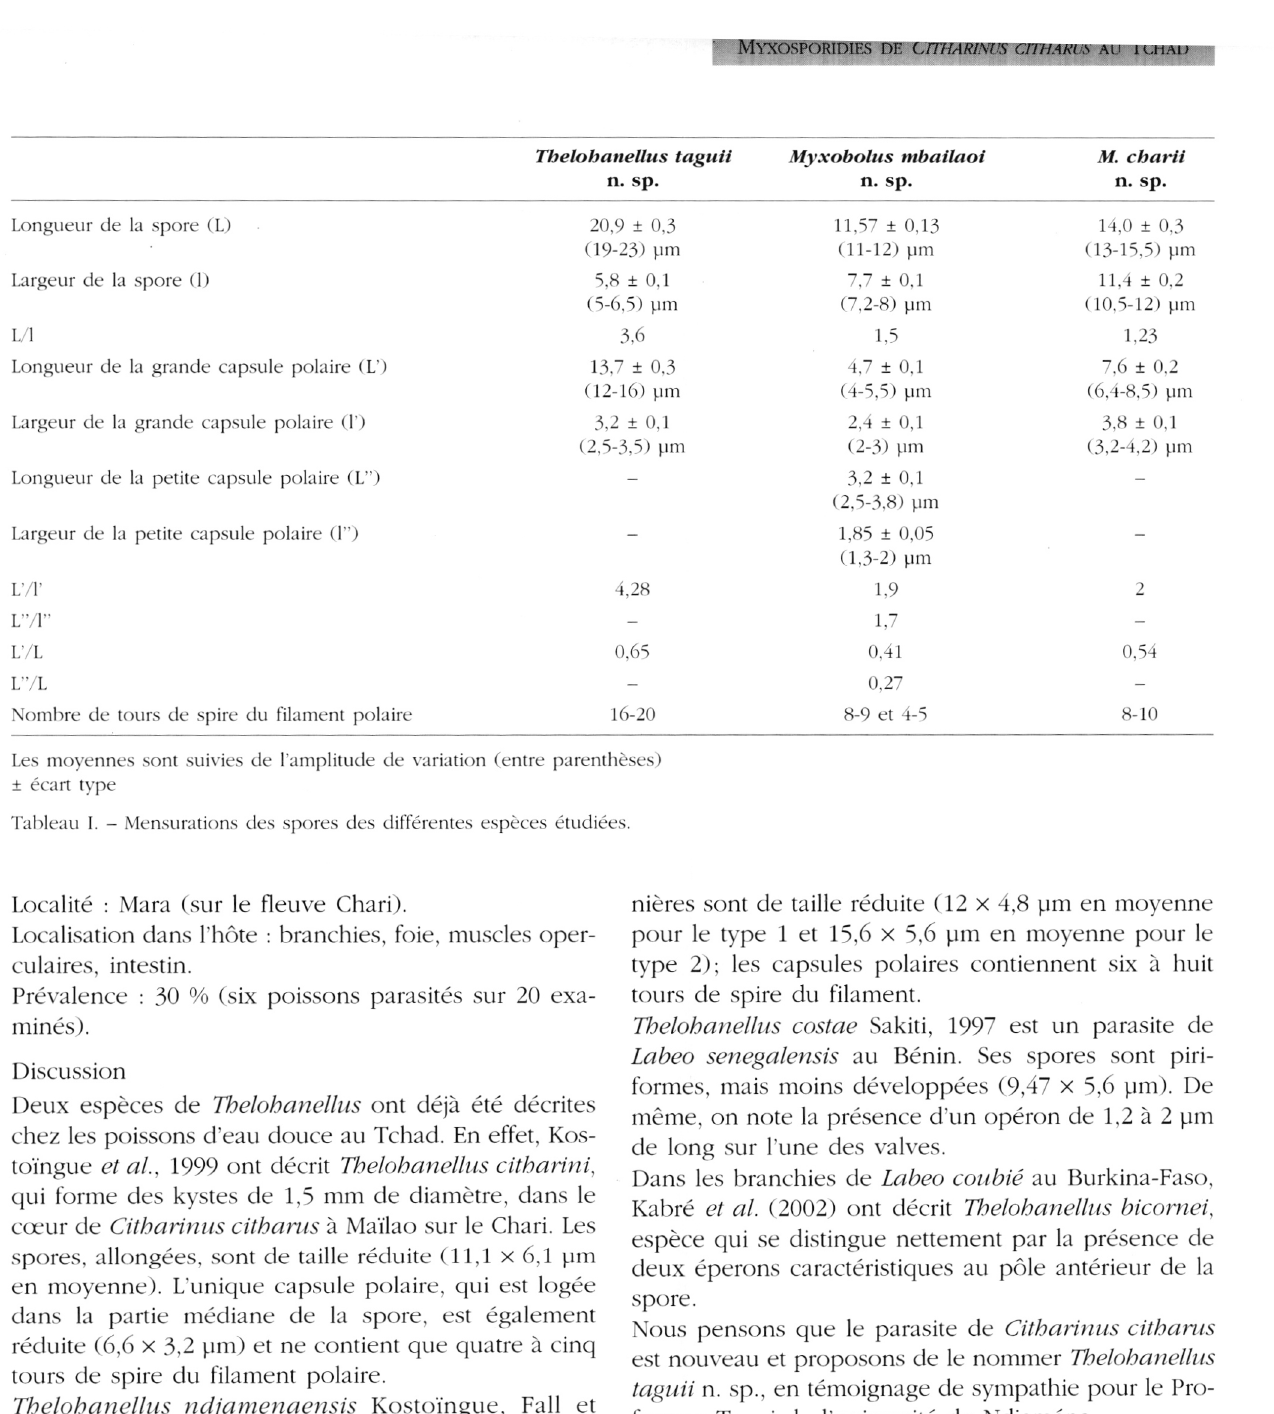
Tableau I. - Mensurations des spores des différentes espèces étudiées.